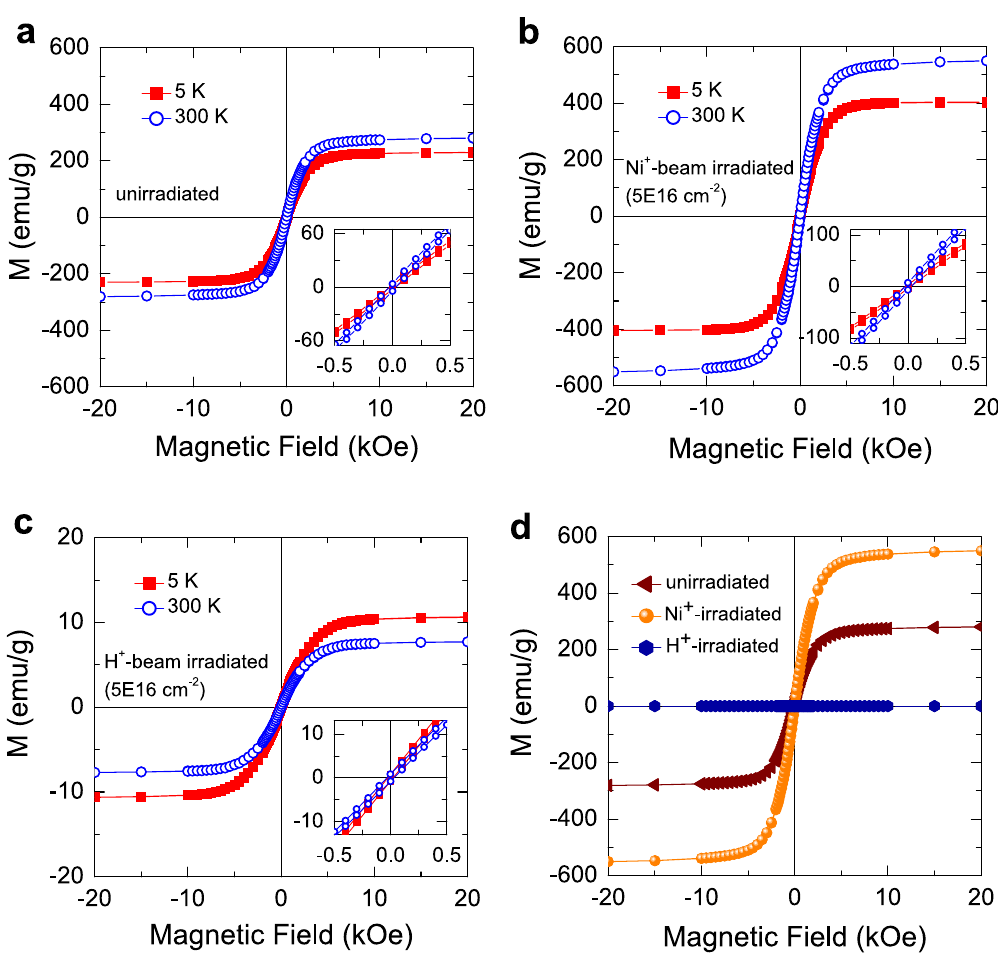
Figure 3. Magnetization curves of ( a ) unirradiated, ( b ) Ni + -beam-irradiated, and ( c ) H + -beam-irradiated CI powders measured at 300 K and 5 K by using SQUID. The inset of each figure shows the curves measured at the lower magnetic field. ( d ) Magnetization curves of unirradiated, Ni + -beam-irradiated and, H + -beam-irradiated CI powders measured at 300 K for